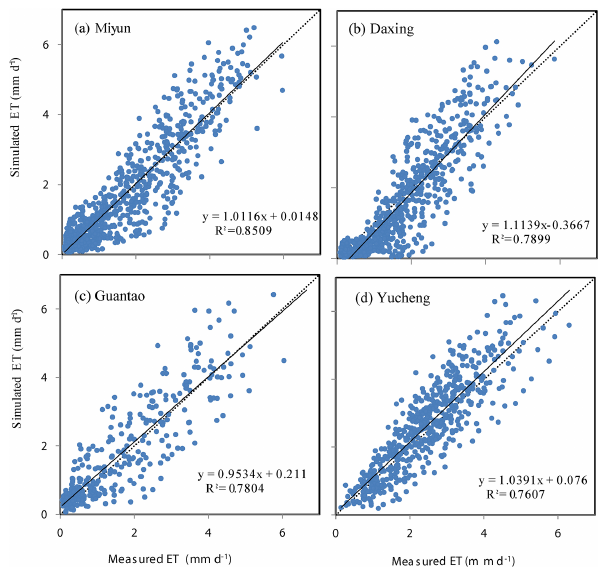
Figure 2. Comparisons of the simulated daily ET with eddy covari- ance measurements.